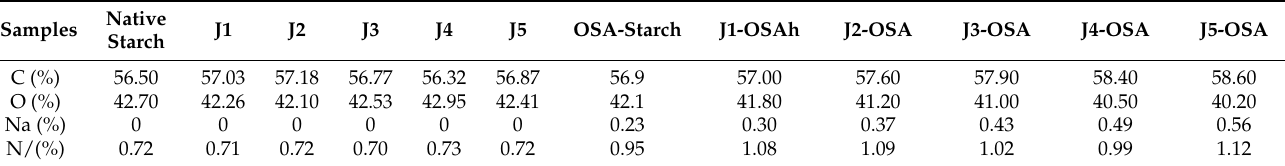
Table 2. Surface elemental composition of J-starch and